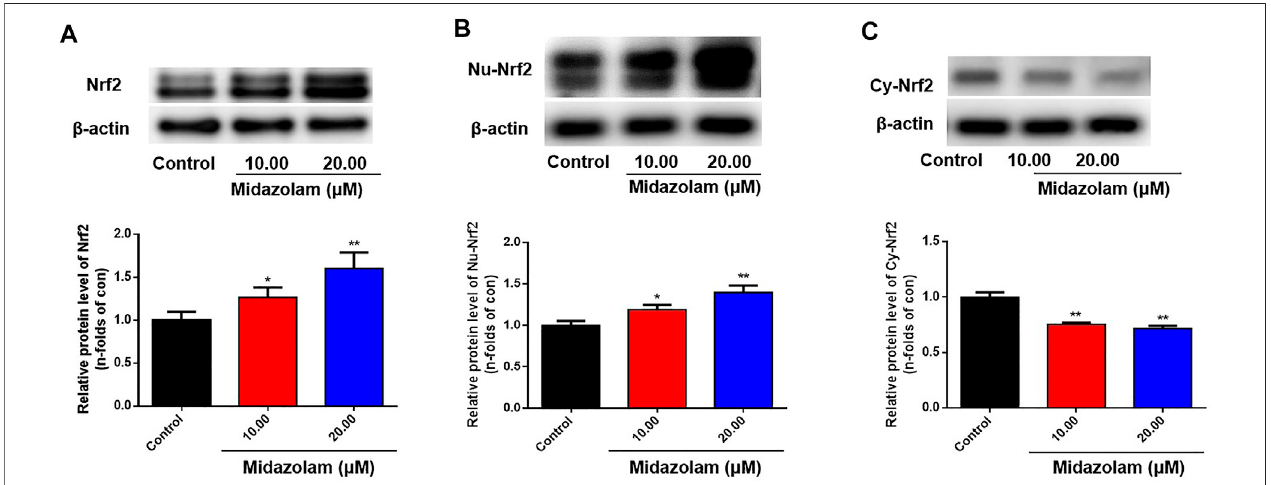
FIGURE 3 | Effects of different concentrations of midazolam on Nrf2 protein level. 293T-Nrf2-luc cells were treated with different concentrations of midazolam (0, 10, 20 μ M) for 24 h, and then using western blot to measure the level of Nrf2 protein. (A) Total Nrf2 protein level in cells; (B) Nrf2 protein level in the nucleus; (C) Nrf2 protein level in the cytoplasm. β -actin was used as an internal control for total protein. The results were shown as mean ± S.D. * p < 0.05 and ** p < 0.01 vs. the control group.